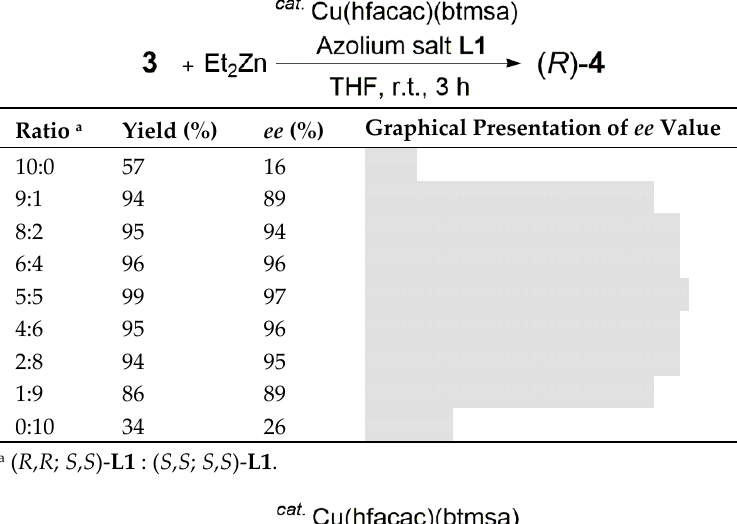
Ratio a Yield (%) ee (%) Graphical Presentation of ee